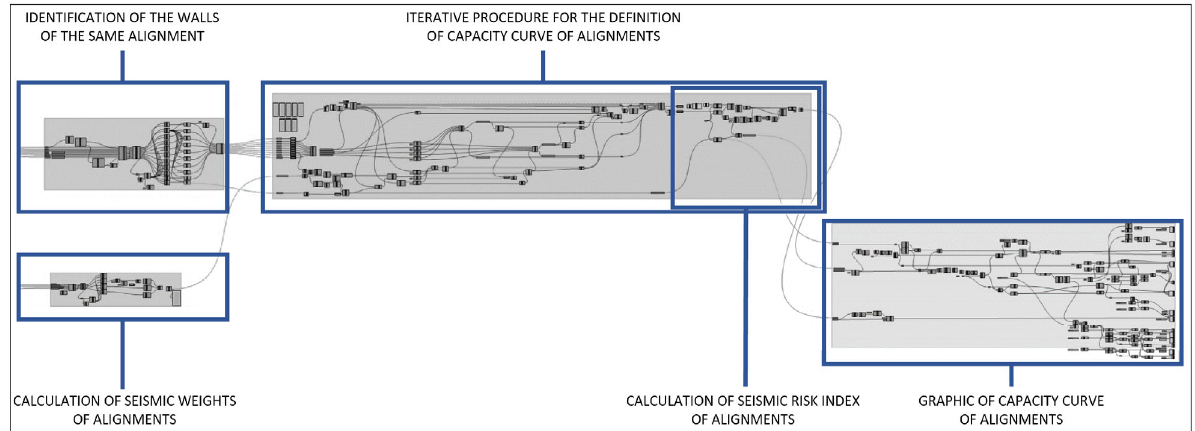
Figure 10. Code developed in Grasshopper to perform non-linear static analysis for alignments of an existing masonry structure.